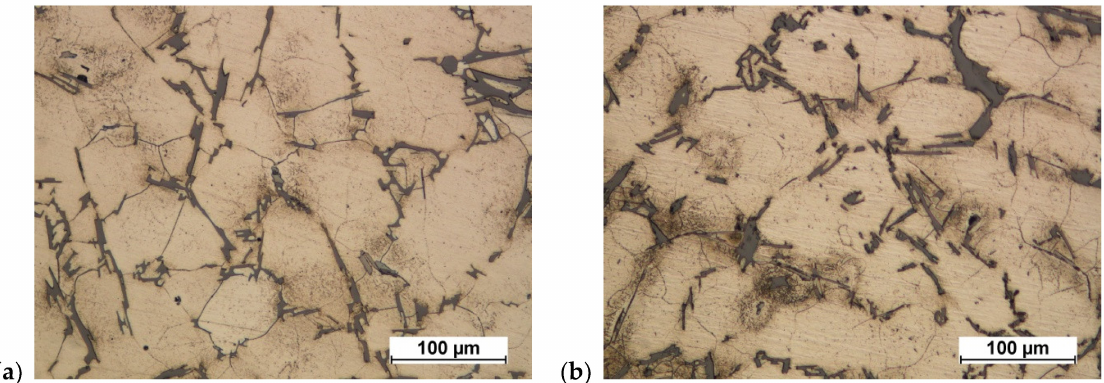
Figure 31. Cast of a connecting rod preform made of AB-71100 aluminum alloy: ( a ) variant 1; ( b ) variant